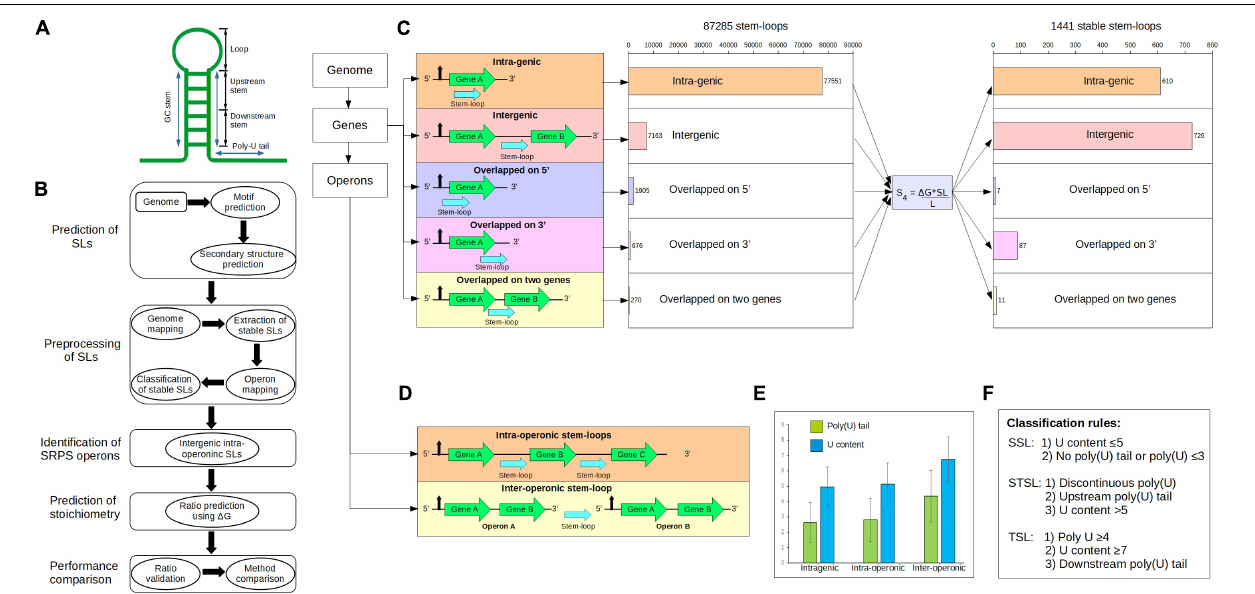
FIGURE 1 | Genome-wide identification of the stem–loops (SLs) in Clostridium cellulolyticum . (A) Typical SL structure in the prokaryotes, which usually consists of a GC stem of 5–10 nucleotides (nts), a loop of 4–8 nts, and a poly(U) tail of 8–10 nts. Here, we further divided the 3 (cid:48) side of the GC stem into two portions: (i) upstream stem: generally upper (near the loop) 60% of the stem region, it mostly harbors less U content; (ii) downstream stem: lower [near the poly(U) tail] 40% of the stem region. (B) Workflow of the ratio prediction. (C) Scheme for SL mapping in genes and operons, which includes the mapping locations of the SLs around genes and operons. SL mapping categorized the SLs into five sets: intragenic, intergenic, overlapped on 5 (cid:48) , overlapped on 3 (cid:48) , and overlapped with two genes. (D) Two kinds of intergenic SLs in operons: first, the intergenic SLs located inside an operon are defined as intra-operonic SLs (598) and generally participate in the regulation of gene expression in SRPS operons; second, the inter-operonic SLs (909), which are located between two operons and typically work as terminator SLs. (E) Distribution of U content and poly(U) tails in the three categories of SLs, which suggests that inter-operonic SLs harbor higher U content and longer poly(U) tails. Bar plot : mean values; error bars : the standard deviations. (F) Classification rules for the SLs, which are based on the U content and poly(U) tails, categorize the SLs into three distinct functional characteristics: (i) SSLs (stabilizer SLs), (ii) STSLs (stabilizer and terminator SLs), and (iii) TSLs (terminator